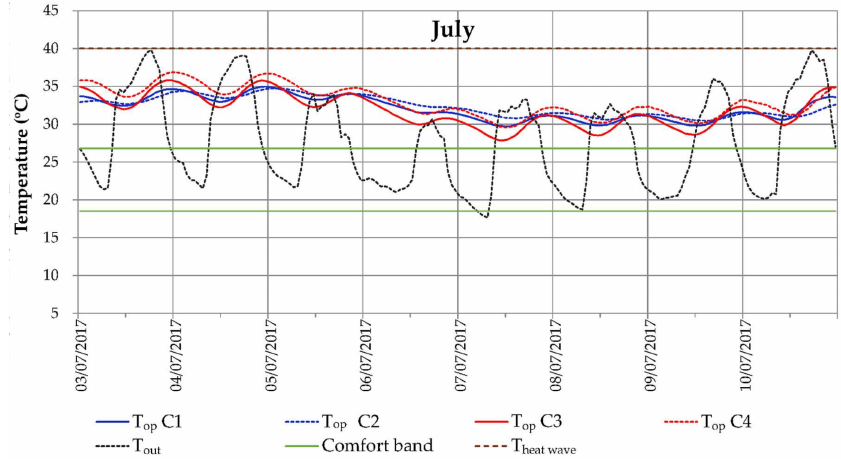
Figure 6. July protocol (no ventilation): Daily evolution of operative temperatures in each cell compared to outdoor temperatures (see Supplementary Materials Figure